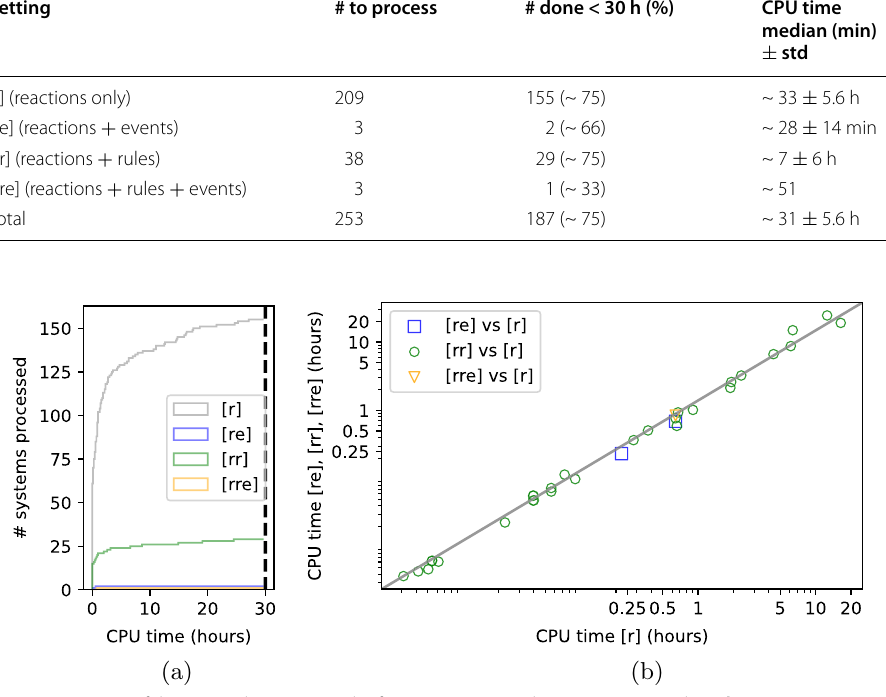
Fig. 5 Runtime of the BN synthesis step in the four settings ( a ) and in comparison with [r] ( b